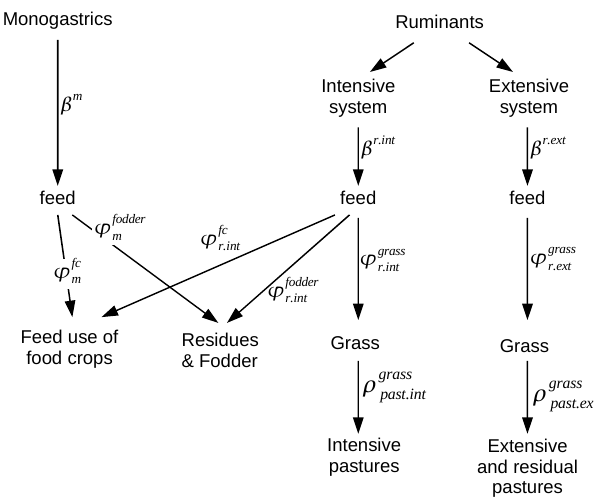
Fig. 10. Links between animal calorie production, feed categories and pasture areas. Reading: the amount of feed required to produce one calorie of monogastric is β m , split into a share φ fc m of food crops and φ fodder m of crop residues and fodder. Values are reported in Ta- bles 4, 5 and